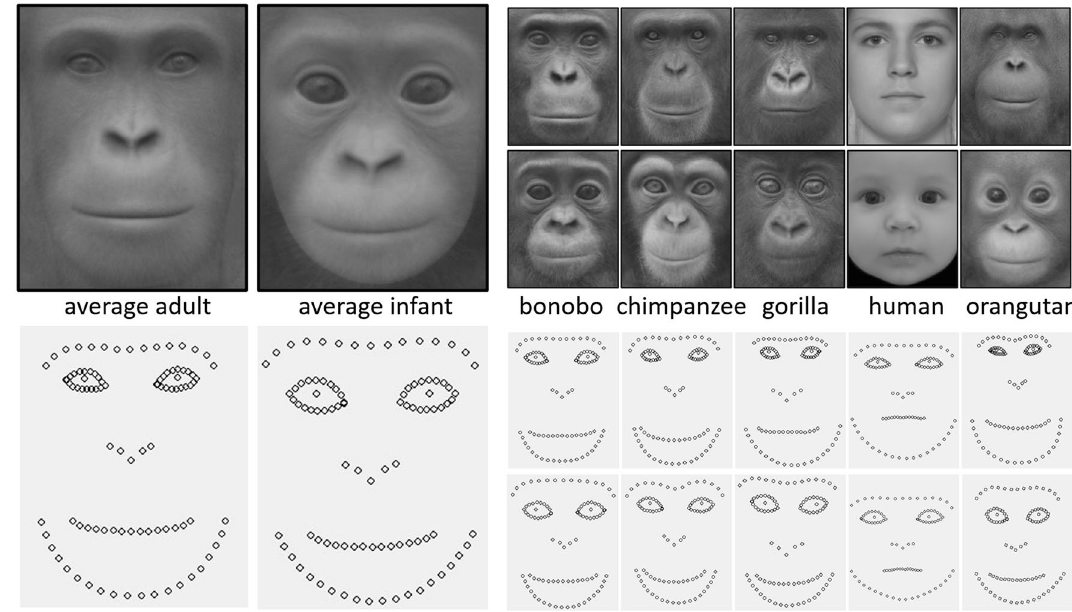
Figure 2. Average adult and infant faces and landmark configurations among five species, and those of each species (top: adults, bottom: